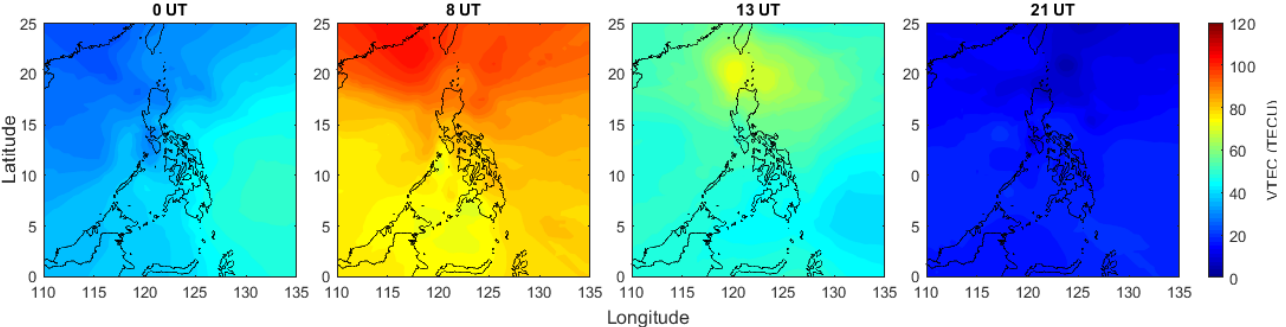
Figure 9. 2-dimensional map of VTEC on an average quiet day of March 2015 at 0 UT, 8 UT, 13 UT and 21